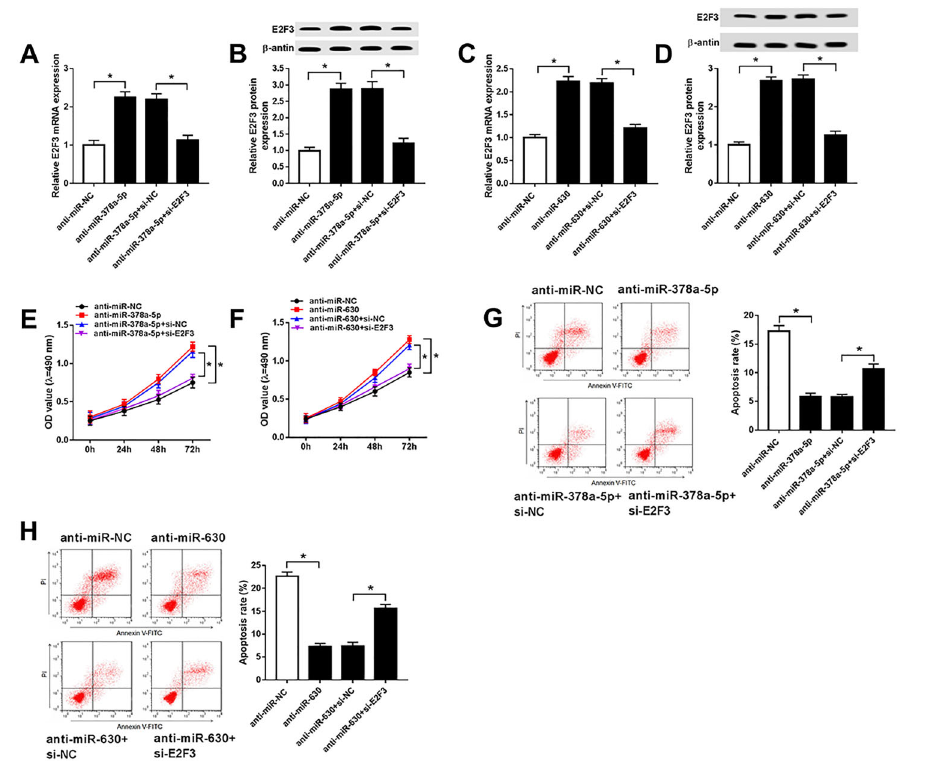
Figure 6. A and B , The expression of E2F3 mRNA and protein in SRA01/04 cells transfected with anti-miR-NC, anti-miR-378a-5p, anti- miR-378a-5p + si-NC, and anti-miR-378a-5p + si-E2F3 was assessed by qRT-PCR and western blot. C and D , The expression of E2F3 mRNA and protein in SRA01/04 cells transfected with anti-miR-NC, anti-miR-630, anti-miR-630 + si-NC, and anti-miR-630 + si-E2F3 was measured by qRT-PCR and western blot. E and F , Detection of cell proliferation in transfected SRA01/04 cells was carried out using MTT assay. G and H , Analysis of cell apoptosis was conducted by fl ow cytometry. *P o 0.05 ( t -test or